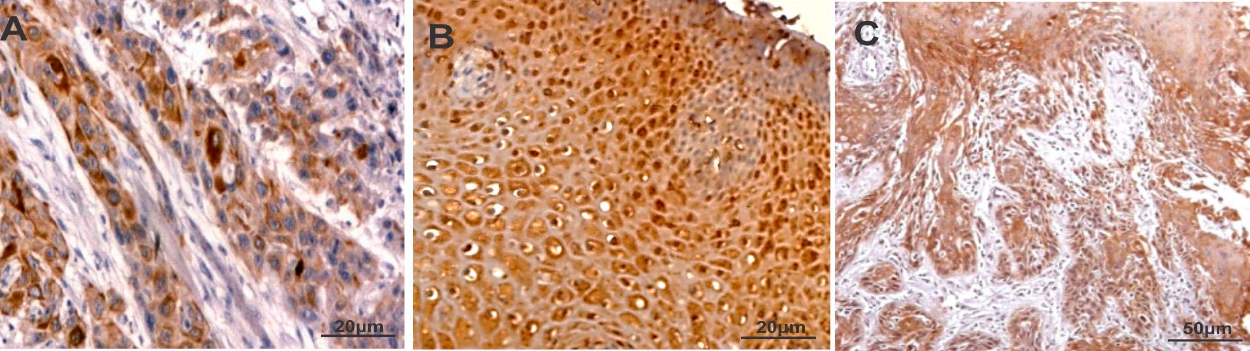
Figure 1. Immunostaining of CXCR-4 ( A ), PKC- δ ( B ) and CD133 ( C ) in oral squamous cell carcinoma. Table 1. Immunodetection of CXCR-4, PKC- δ and CD133 in oral squamous cell